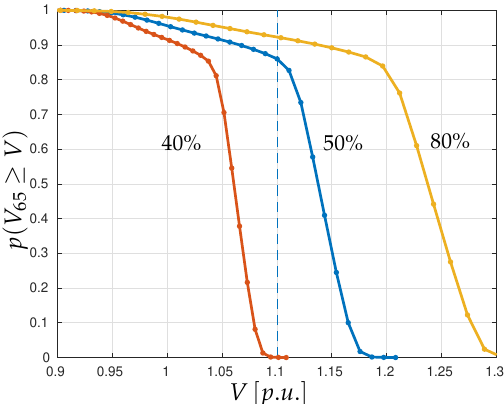
Table 2. Methods Comparison. Figure 9. Probability of violating upper value V for growing penetration levels α computed with PWL method.